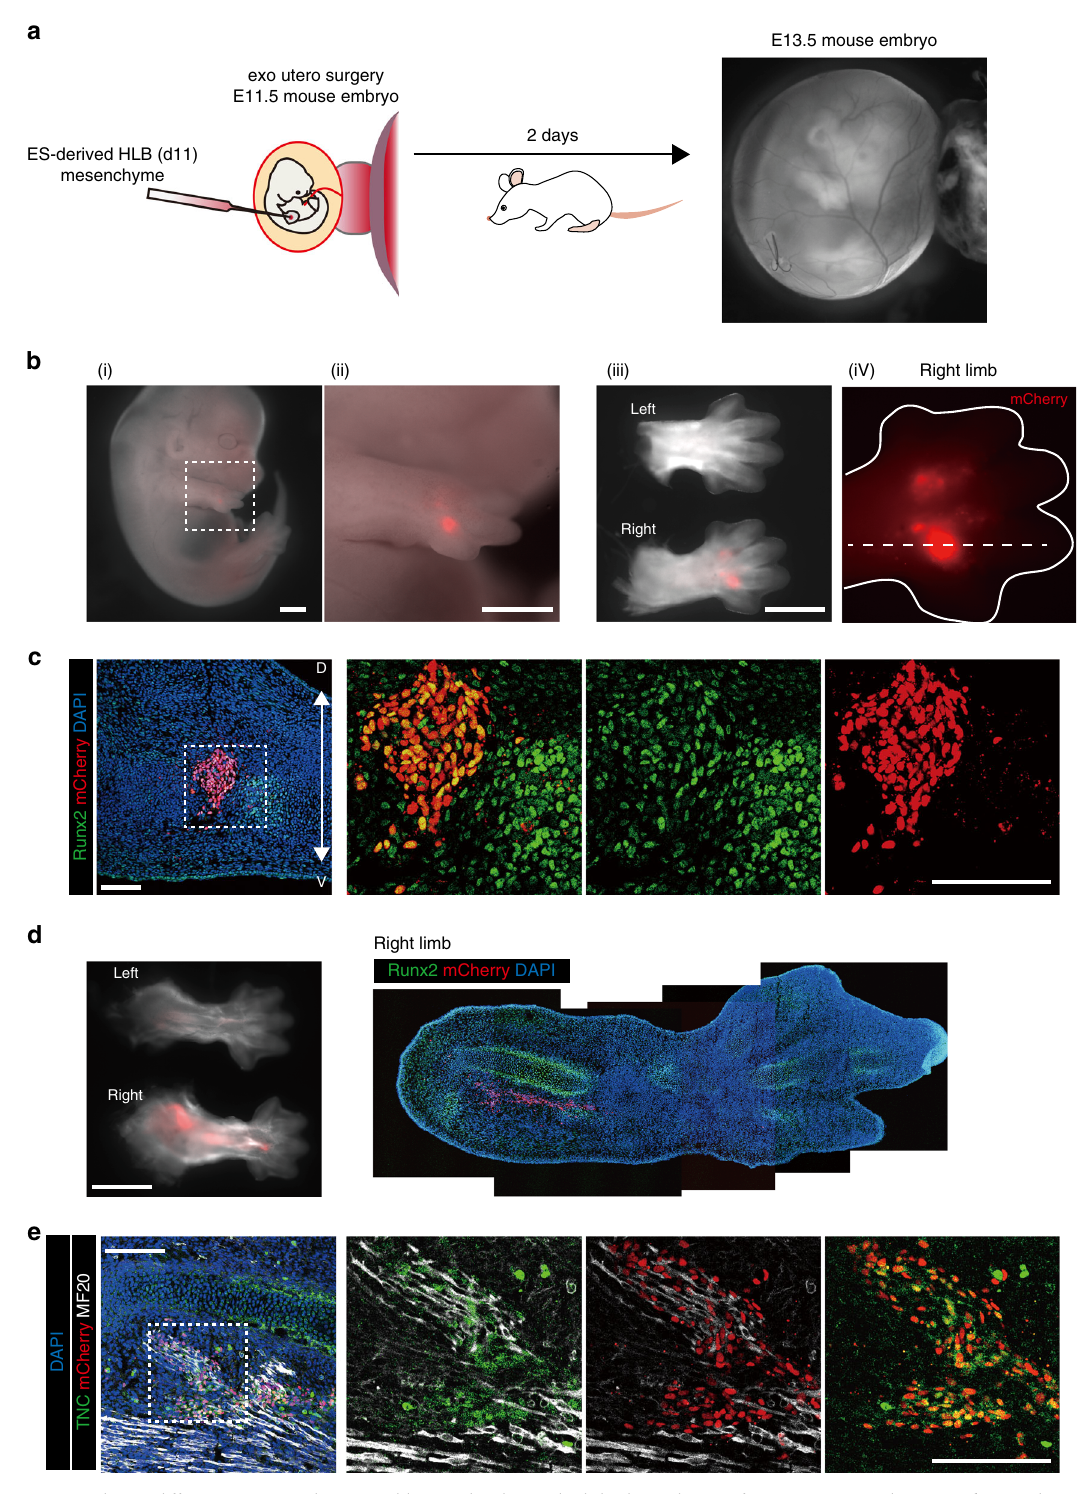
Fig. 5 ES – HLB mesenchyme differentiates into digit osteoblast in developing limb bud. a Scheme of exo utero transplantation. b Two days post grafting. ES – HLB (pCAG-H2B::mCherry line) grafted into embryonic right-forelimb bud. ii shows an enlarged view of the dotted box of i. iii shows a comparison between non-grafted (upper) and grafted (lower) forelimb bud. iv shows enlarged view of mCherry + transplant site in the right-forelimb bud. White line and dotted vertical line indicate the limb bud form and sectional position, respectively. Scale bars, 1 mm. c Immunostaining of transverse section of the grafted position ( b , iv). ES – HLB mesenchymal cells (mCherry + ) were organized into osteogenesis of digit (Runx2 + ). d Mouse hindlimb bud at 2 days post transplantation. ES – HLB (pCAG-H2B::mCherry line) grafted into right hindlimb bud ( d , left panel). The sagittal section of transplanted right-limb bud indicates ES – HLB mesenchyme (mCherry + ) adapted limb development along with the limb elongation ( d , right panel). e Sagittal sections showing ES – HLB mesenchyme (mCherry + ) differentiated into tendon (TNC + ) as part of muscle (MF20 + )-tendon unit (the right pictures indicate higher magni fi cations of the white dotted box areas in the each of the left picture). Scale bars, 100 μ